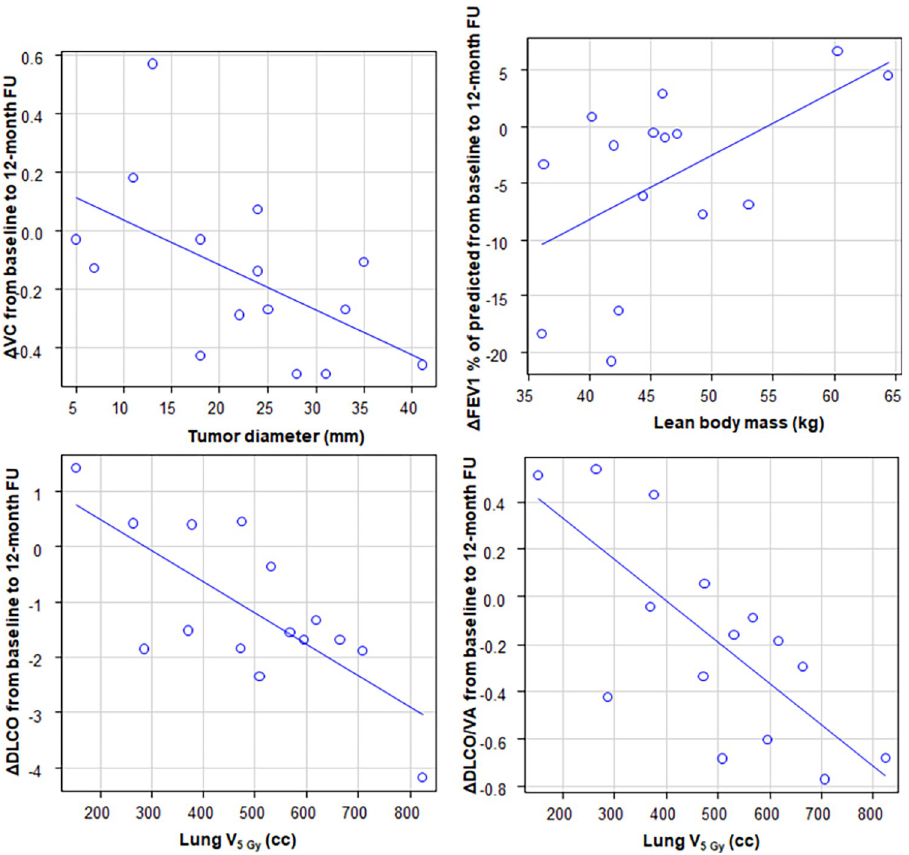
Fig 2. Scatter plots with regression lines of Δ VC, Δ FEV1% of predicted, Δ DLCO and Δ DLCO/VA with significant correlation